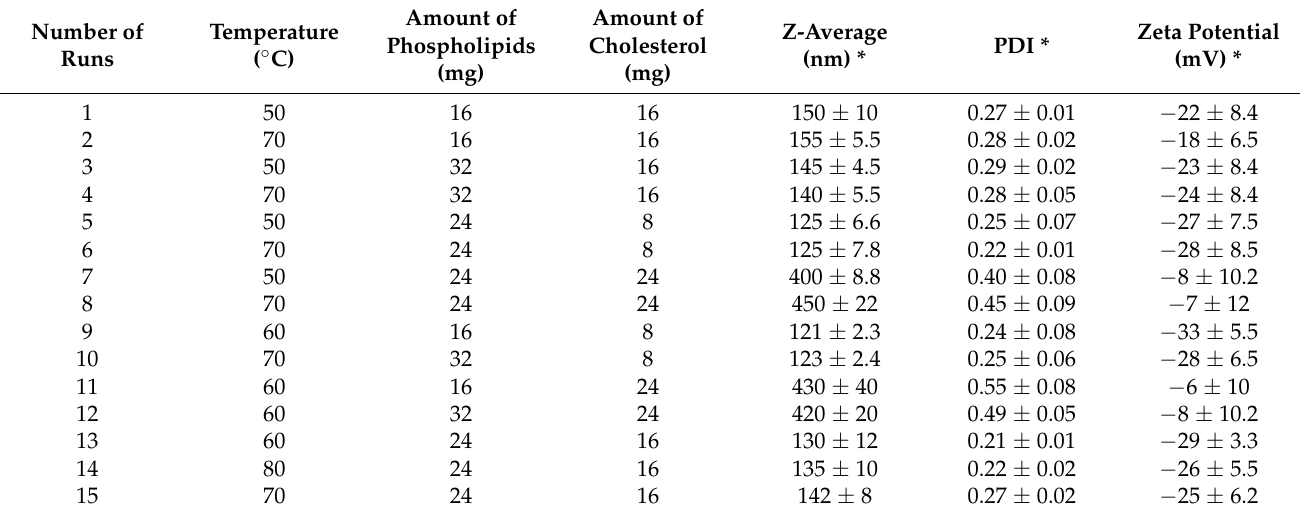
Table 2. Z-average, polydispersity index (PDI), and zeta potential of 15 runs on the design of